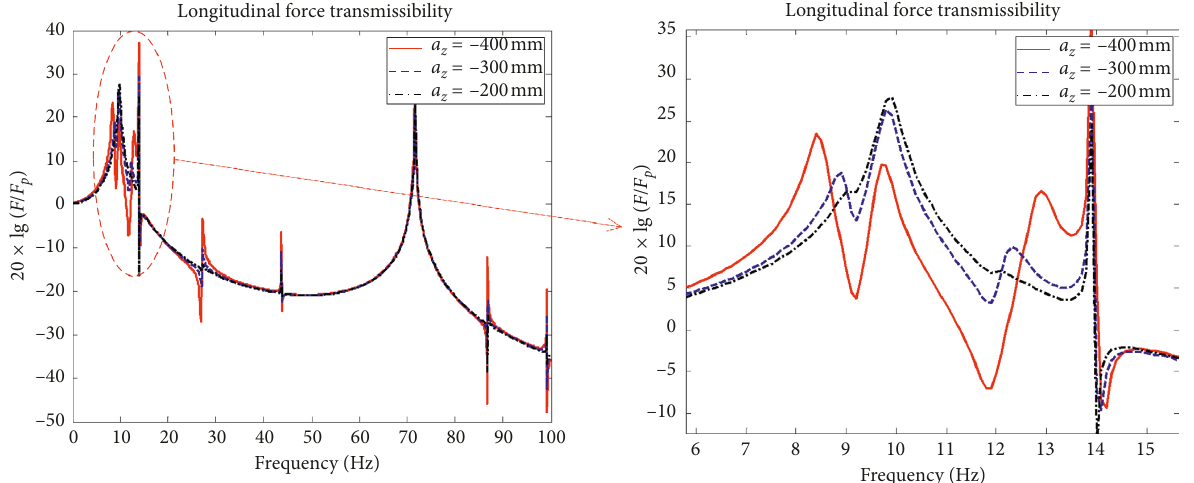
Figure 15: Longitudinal force transmissibility with different vertical arrangement a